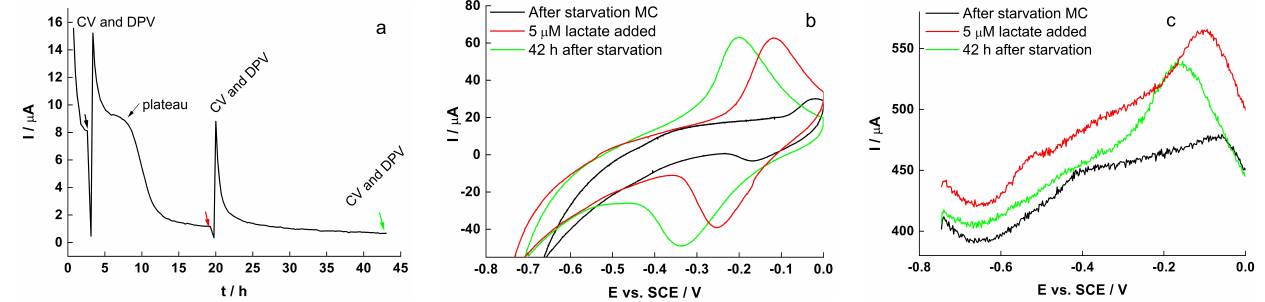
Figure 6. ( a ) CA, ( b ) CV and ( c ) DPV of early S. loihica PV-4 biofilm on RVC during starvation. The time t = 0 correspond to 48 h of growth at 0.24 V.